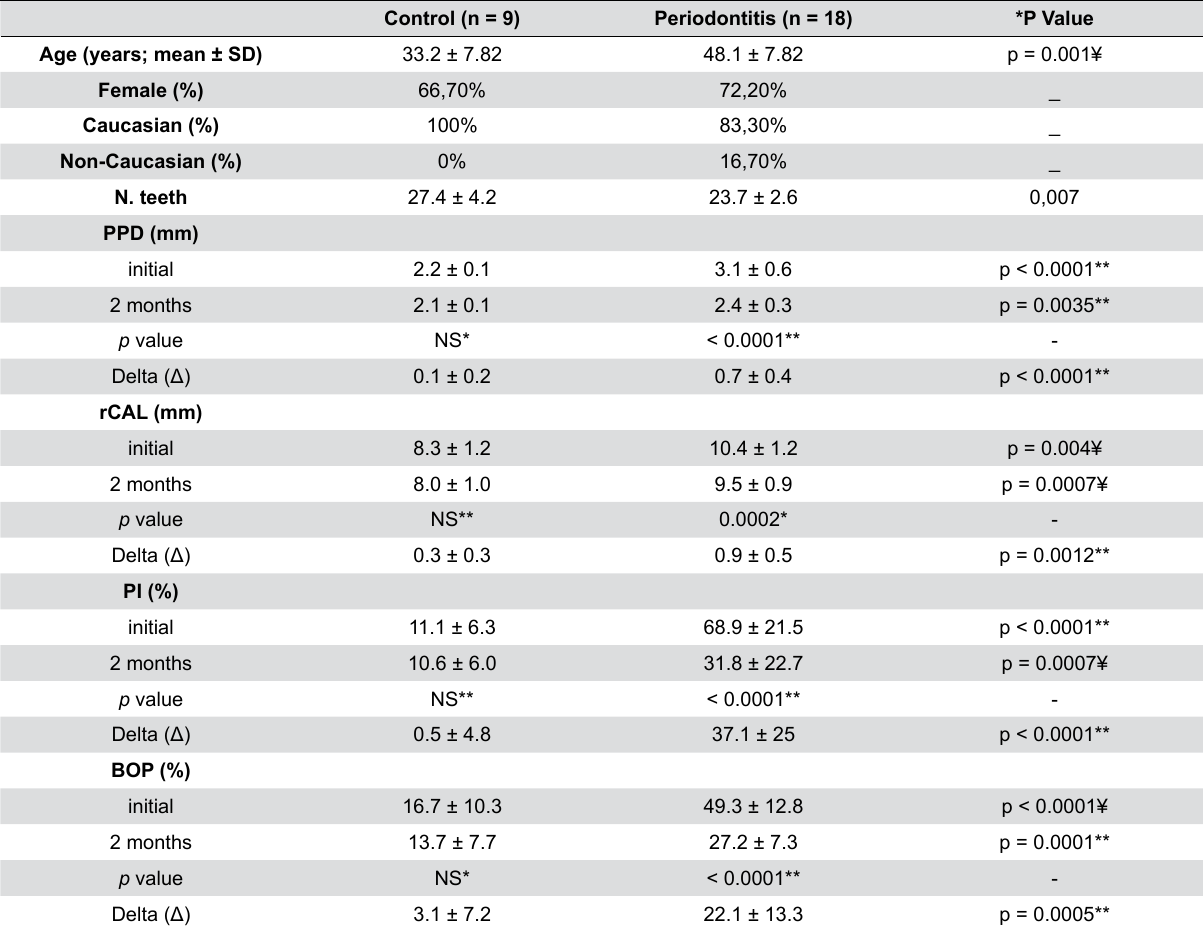
Table 1- Demographic and clinical data from Control and CP groups. NS - non significant (p>0.05). Mean ± standard deviation. * Wilcoxon test for intragroup comparisons; ** t test for intragroup comparisons and between two groups; ¥ Mann-Whitney test for comparisons